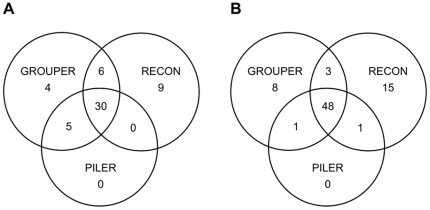
Venn diagram showing the gains achieved by combining several clustering programs.(A) Combining the GROUPER and RECON programs in particular makes it possible to fully recover more TE sequences than each program alone from the D. melanogaster genome. (B) Same conclusion from the A. thaliana genome.